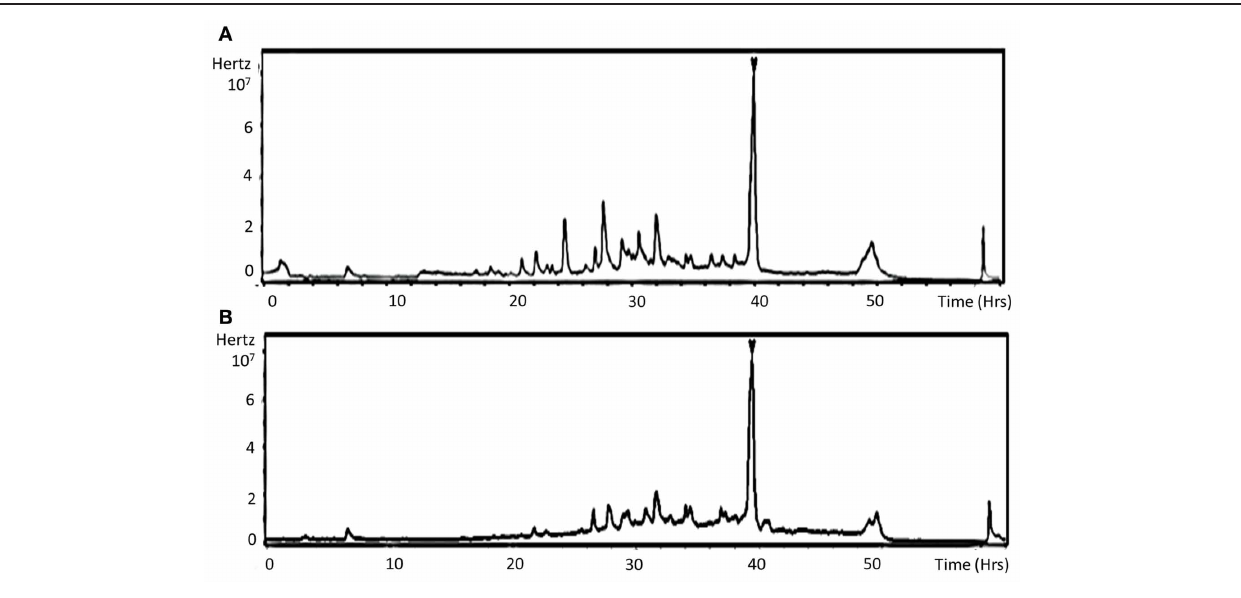
FIGURE 12 | Detection of the phytotoxin brassicicolin A in organic extracts from the culture broths of both the wild-type strain and the (cid:2)(cid:2) abmpd-abmdh mutant. LC-MS total ion chromatograms